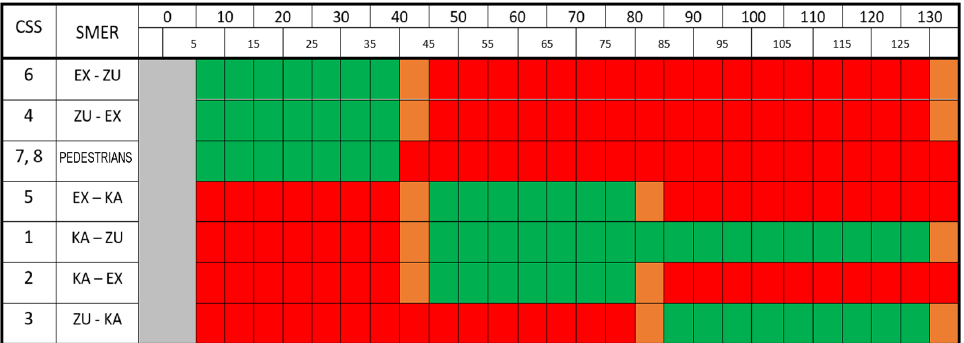
Figure 18. Example of graphic representation of the road light signaling cycle.